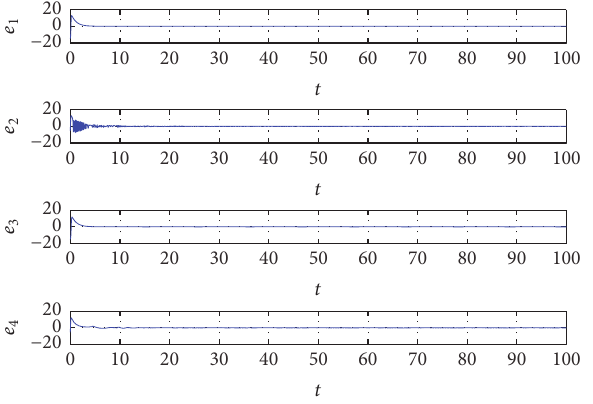
Figure 5: Time series of error of parameters